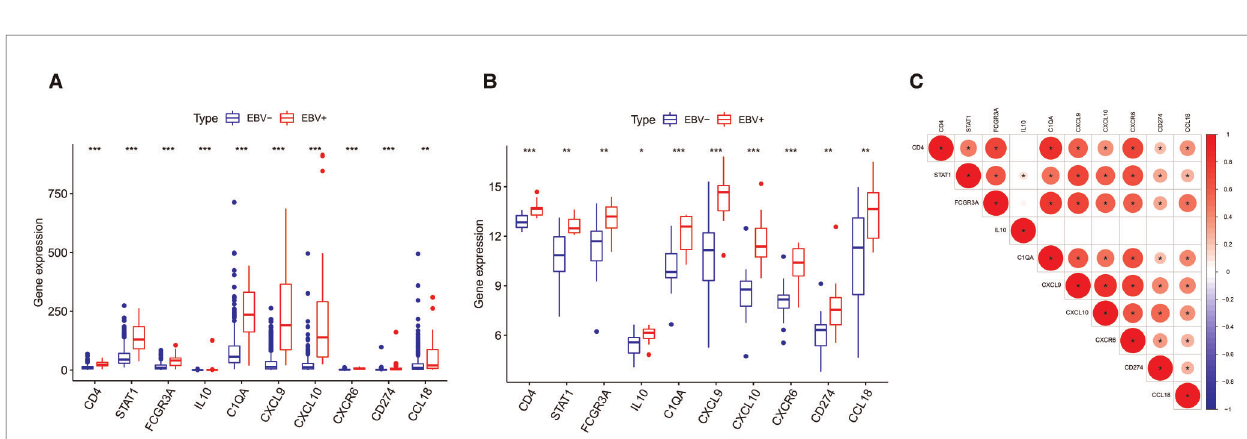
FIGURE 6 | Differences in HUB gene expression levels. ( A ) Relative expression levels of HUB genes in the TCGA cohort. ( B ) Validation in the GEO cohort. ( C ) Correlation between the HUB